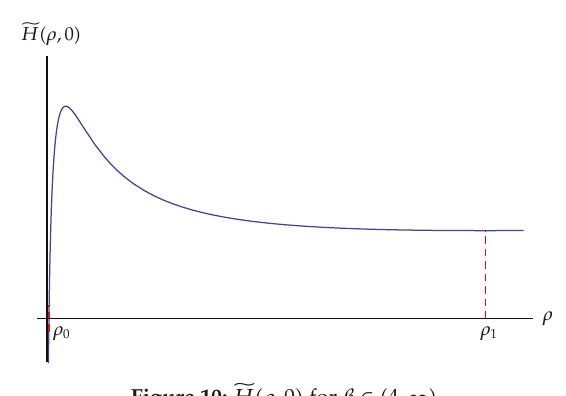
(cid:22) H (cid:4) ρ, 0 (cid:5) for β ∈ (cid:4) 0 , 4 (cid:9) .